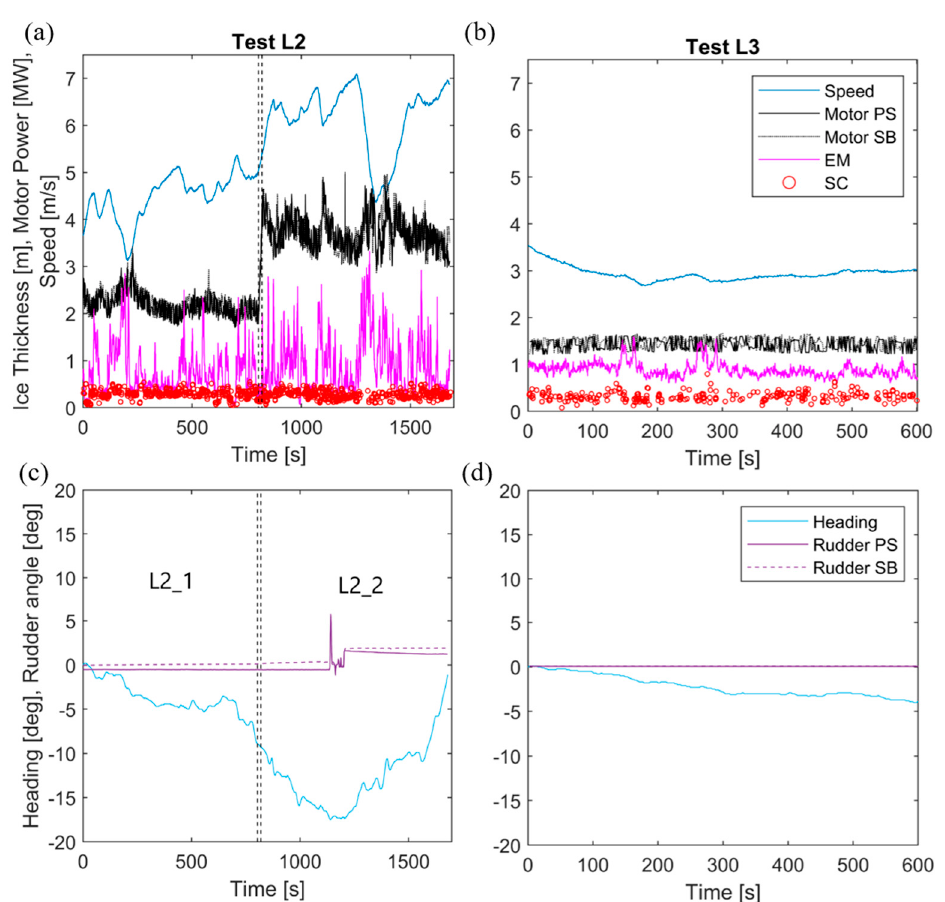
Figure A1. Applied motor power, measured ice thickness with the electromagnetic device (EM) and stereo camera system (SC), and obtained speed during tests ( a ) L2_1 and L2_2, and ( b ) L3. Applied rudder angles with obtained heading during tests ( c ) L2_1 and L2_2, and ( d ) L3.